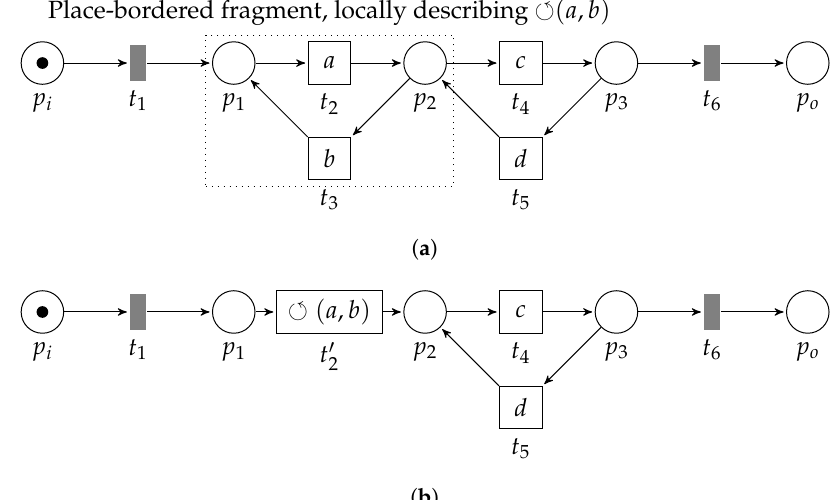
Figure 8. Example WF-net (and a corresponding reduction) in which we are able to detect feasible patterns ( (cid:9) ( a , b ) and (cid:9) ( c , d ) ) that are not globally language preserving. In the exemplary reduced net (Figure 8b), once we have executed t (cid:48) , we are only able to execute the loop construct between t 4 and t 5 . 2 ( a ) The WF-net containing two local language equivalent feasible patterns. ( b ) The (PTree)WF-net after reduction of the loop pattern between t 2 and t 3